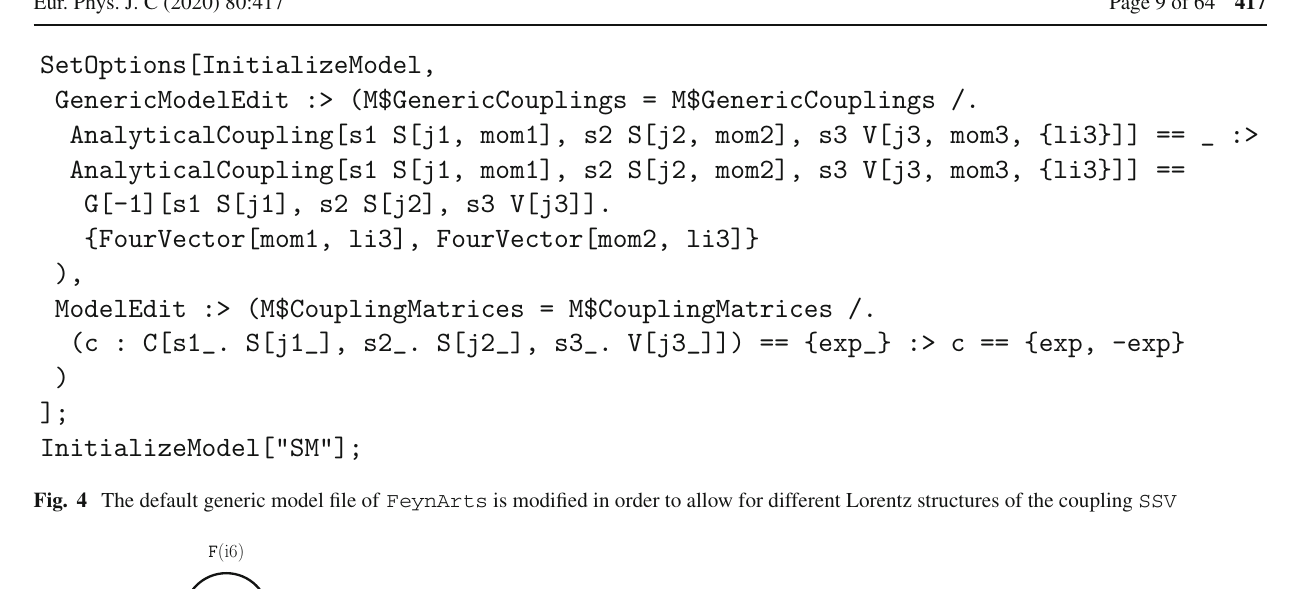
Fig. 4 The default generic model file of FeynArts is modified in order to allow for different Lorentz structures of the coupling SSV